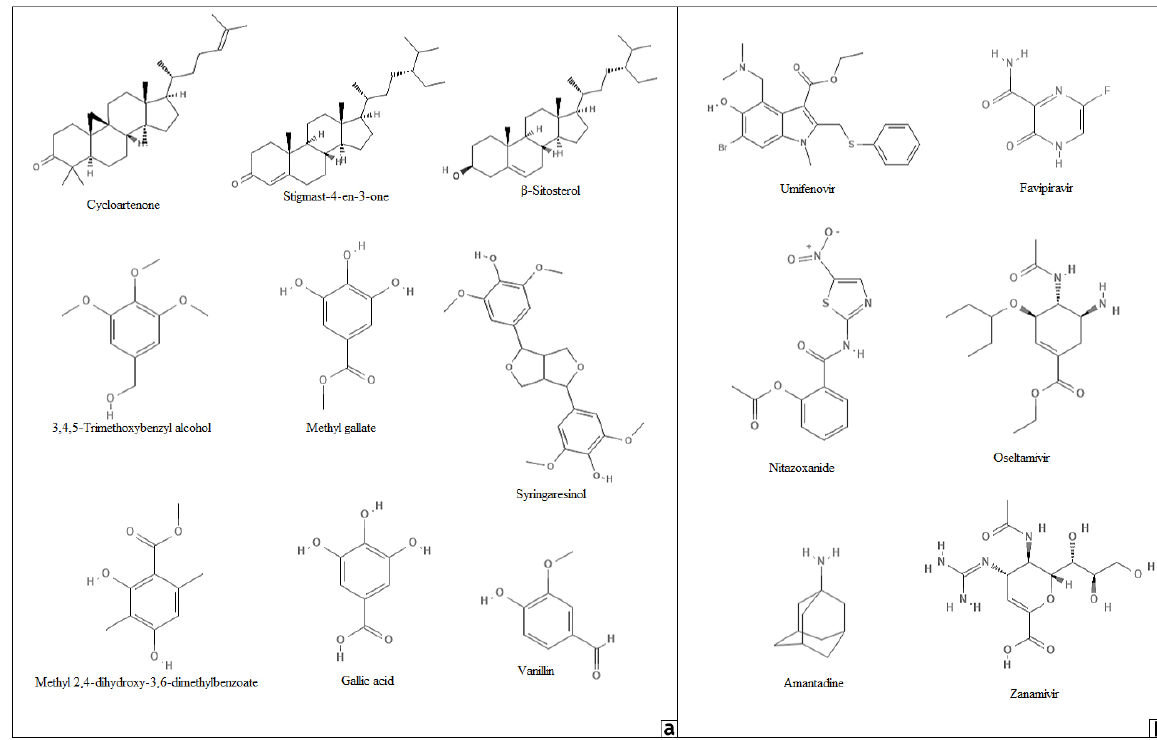
Figure 1. S. brasiliensis phytocompounds (a) and antiviral drugs’ chemical structures